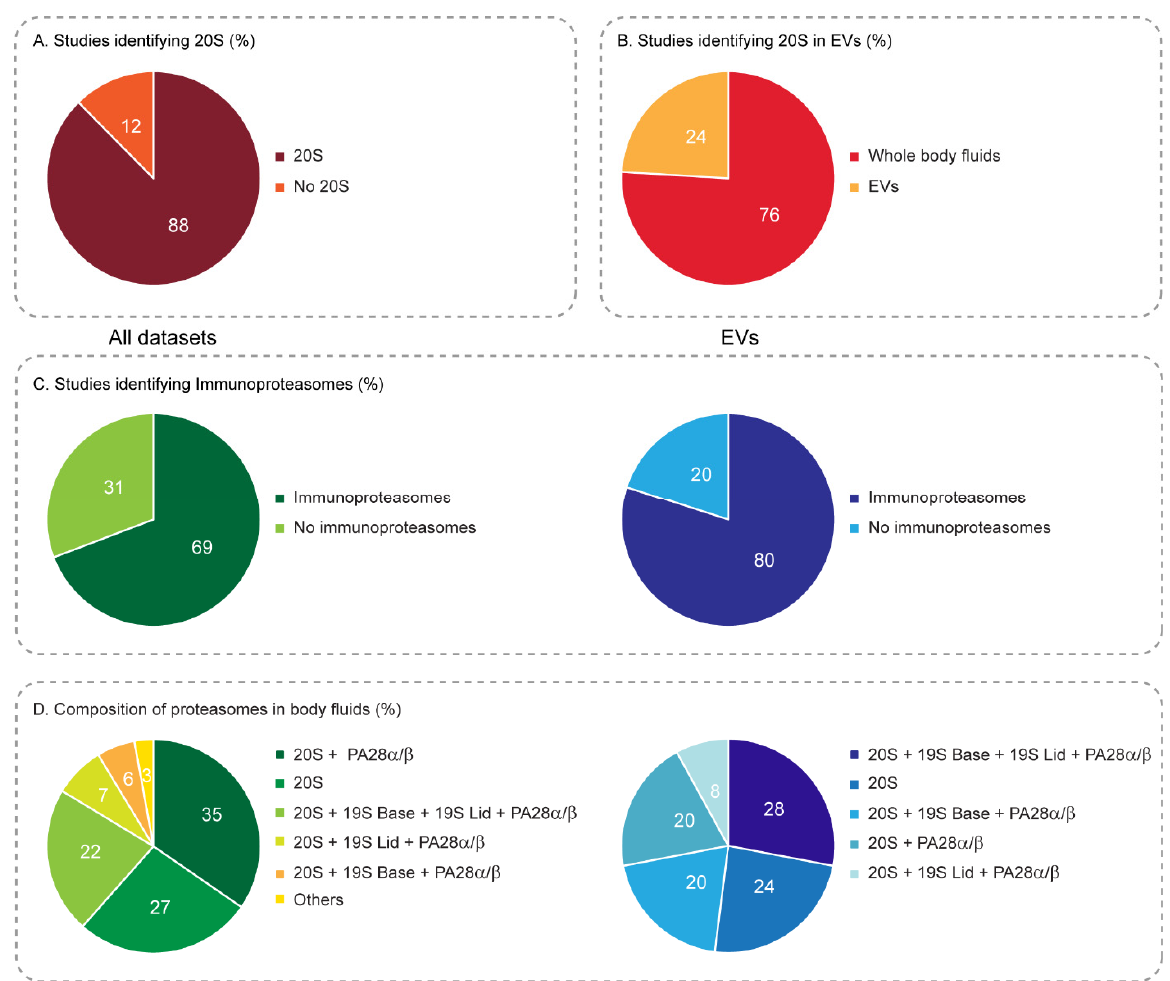
Figure 3. Overall characteristics of proteasome subunits in extracellular fluids. ( A ) Overall, 143 proteomic datasets of body fluids were examined. Proteasome subunits were identified in 88% of these studies. ( B ) Here, 76% of the studies were performed on whole body fluids and 24% were performed on body fluid EVs. ( C , D ) Percentage of studies identifying at least six 20S proteasome subunits, either in the overall body fluid (left panels) or enclosed within EVs (right panels). ( C ) Immunoproteasome subunits were identified in 69% of the datasets and in 80% of the EV-focused studies, suggesting that immunoproteasomes play a significant role in EVs. ( D ) Composition of proteasome subunits in the different body fluids (left panel) and in EVs (right panel). Other species denote datasets identifying the 20S + 19S base, 20S + 19S lid, 20S + 19S base + 19S lid, each found in 1% of the datasets.